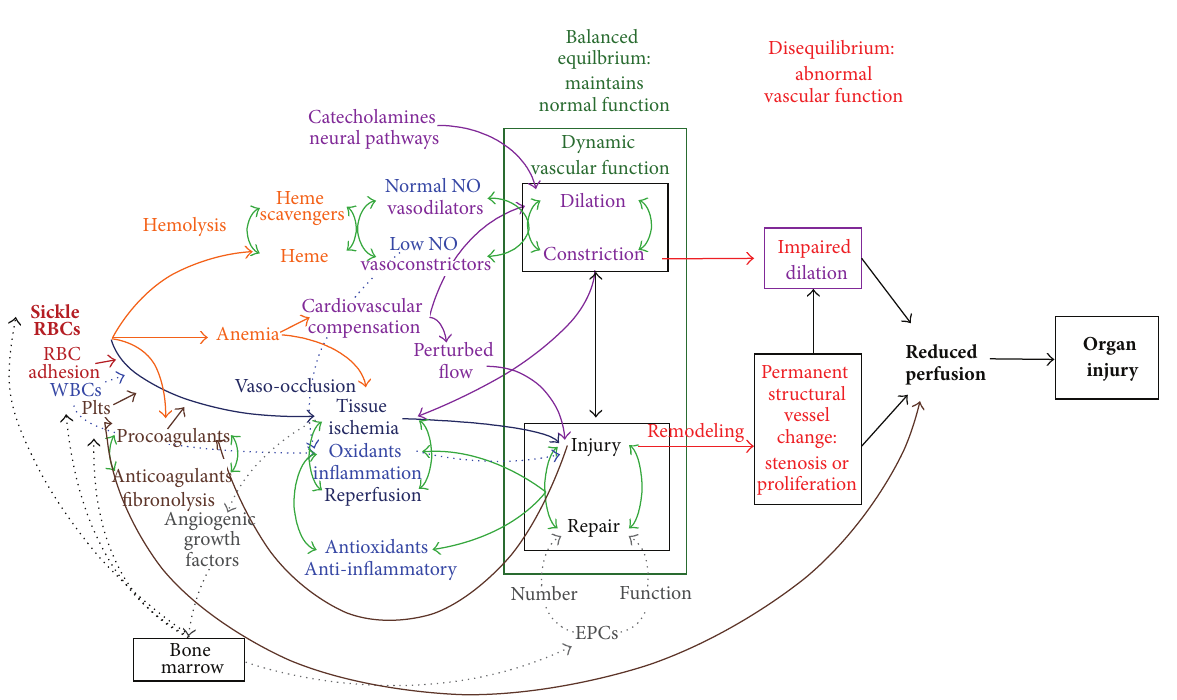
Figure 2: Chronic vasculopathy model. This diagram shows proposed interactions between pathophysiologic mechanisms in sickle cell disease that lead to chronic vasculopathy and organ injury. Key to mechanisms: Green arrows: balancing feedback loops, Red: abnormal vascular structureand function, orange: hemolysis, light blue: inflammation and oxidant stress,dark blue: ischemia and reperfusion, lavender: vasomotor, brown: coagulation, and gray: angiogenesis. See text for